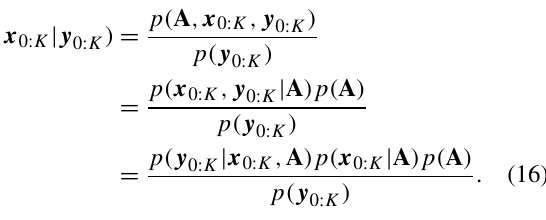
which would require finding the maximum